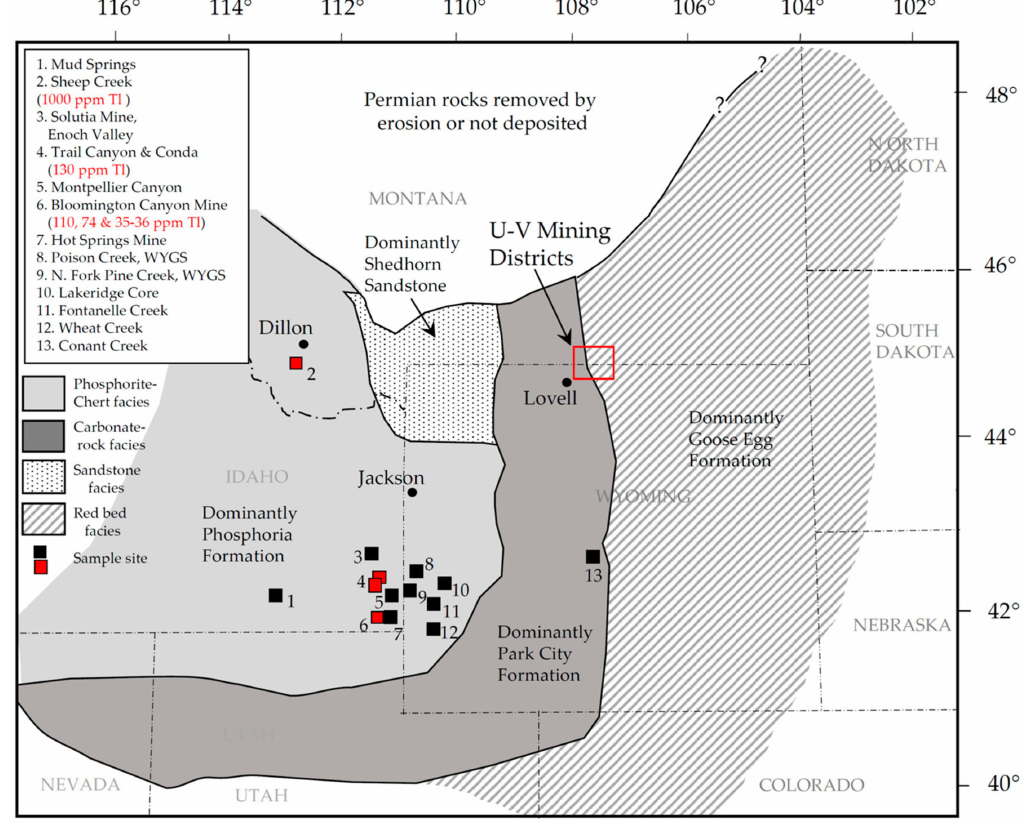
Figure 10. Index map showing location of dominant facies of rocks of Permian age. The numbered sites (filled squares) give the approximate location of the sample sites for which samples have been analyzed for major-element oxides and trace elements in previous studies [66,67,69,70,74,75,77]. Red filled squares are sites that had samples with greater than 100 ppm concentration of Tl. The map is adapted from Sheldon, 1963 [65] and locations from the different